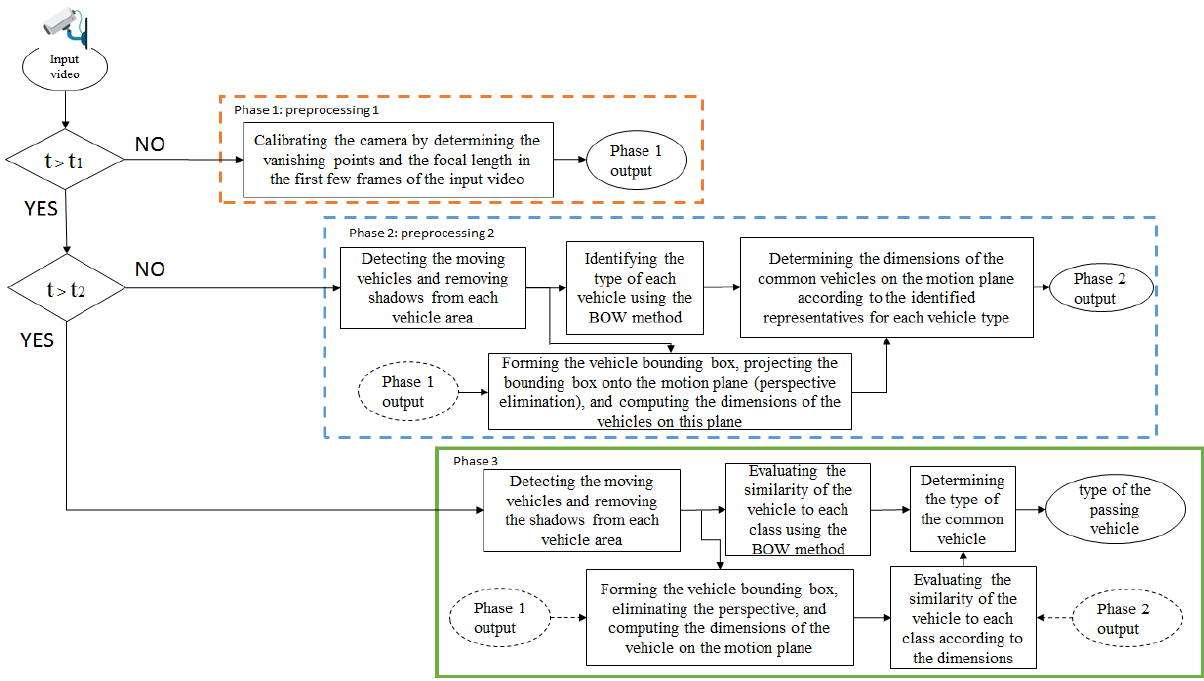
Figure 1. Flowchart of the proposed